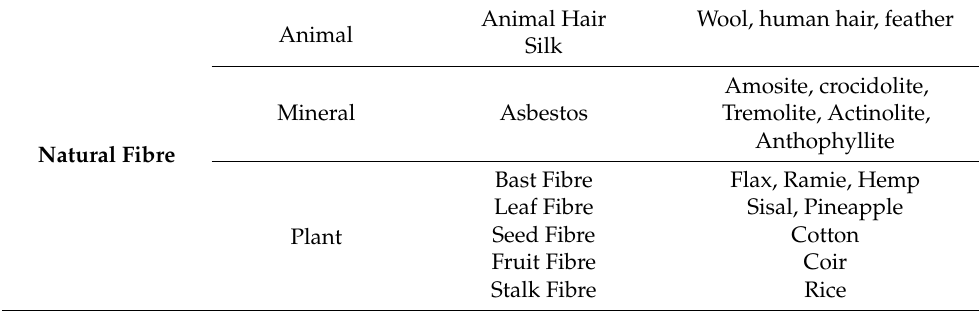
Table 1. Classifications of natural fibers. Adapted from [16] with permission from Elsevier, 2022.